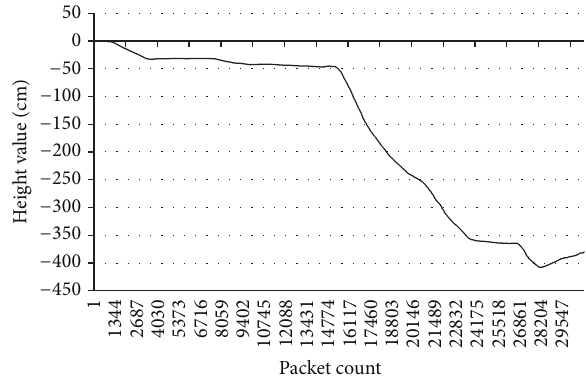
Figure 5: Slope of the geography used in the experiment.